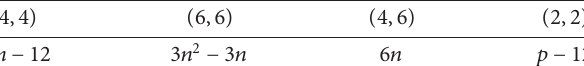
∗ for HGSCNC ( n, m ) . (b) Comparison of 1 , ZC 2 , and ZC 1